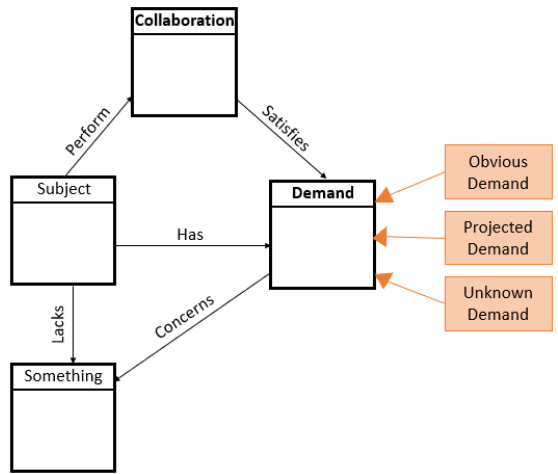
Figure 4. Need for